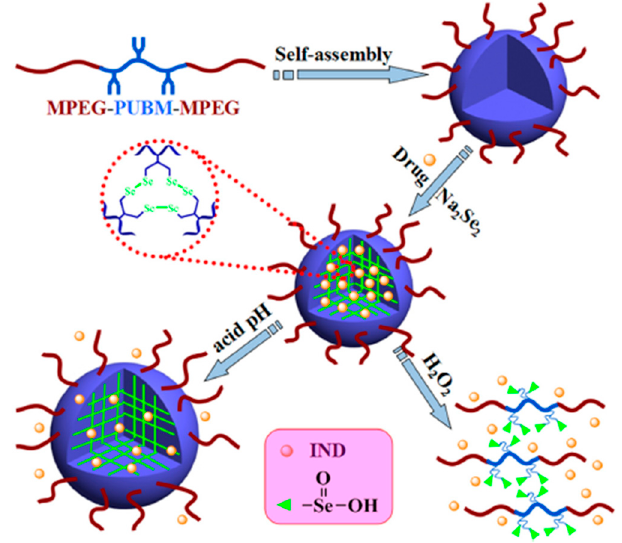
Figure 14. The PEGylated PU self-assembled into nanogels; the model drug, indomethacin (IND), and diselenide bonds were incorporated into the nanogels, forming a network. At lower pH environments, MDEA protonates, causing swelling and expansion of networks; at high H 2 O 2 concentration, diselenide bonds break, causing network collapse; both result in release of IND (Adapted and reprinted with permission from ref. [108] © 2016, Elesevier).